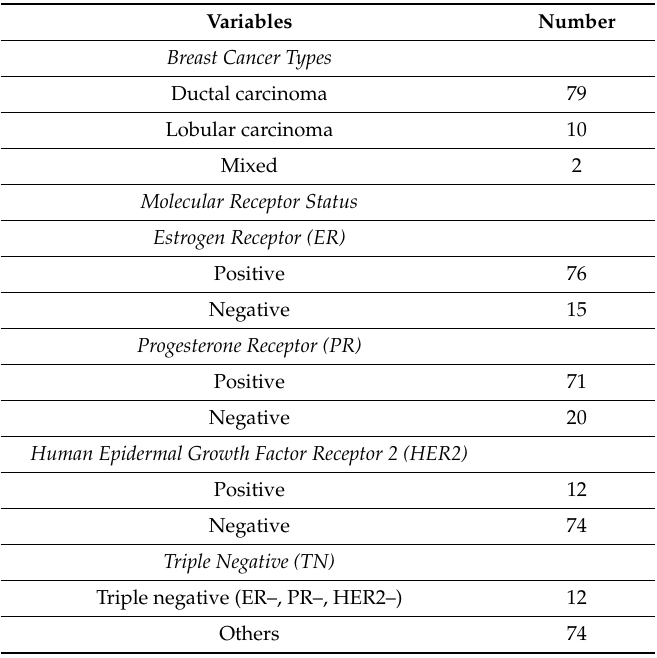
Table 1. Clinical